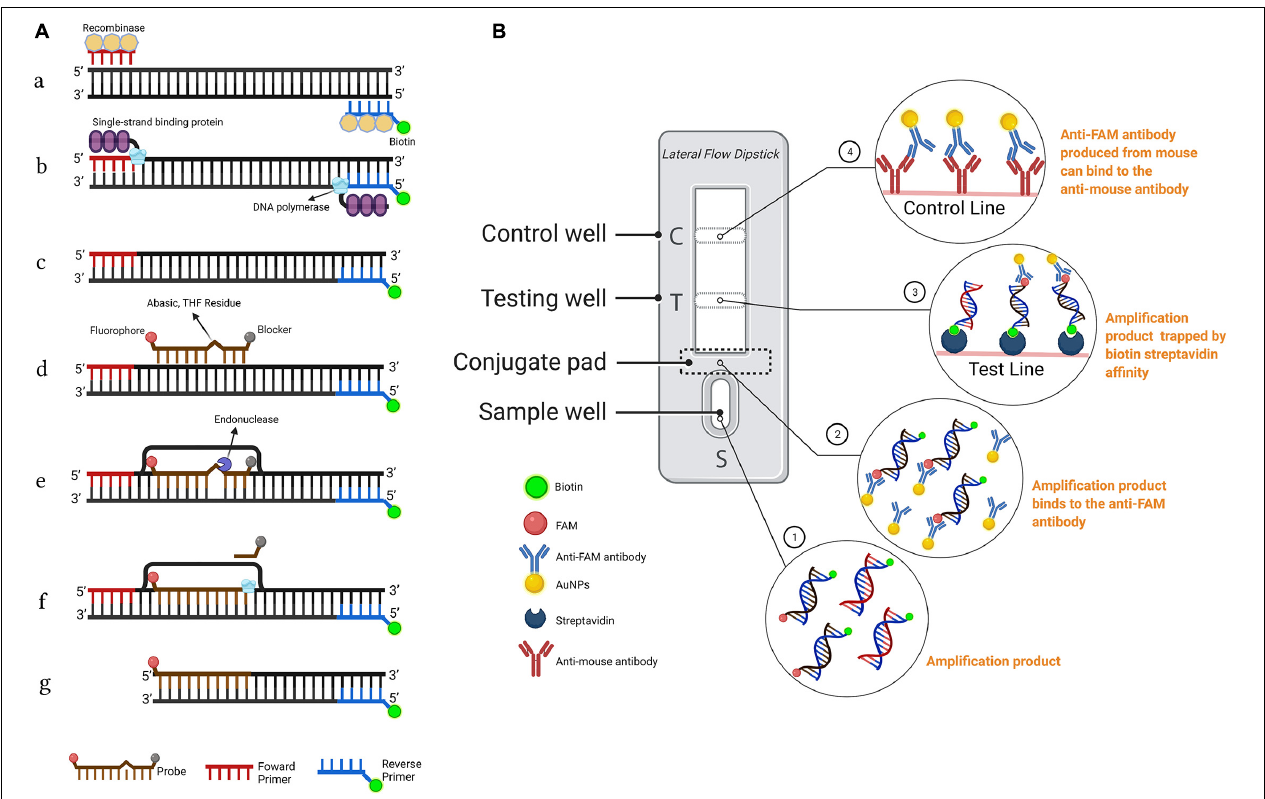
FIGURE 1 | Schematic representation of the recombinase polymerase amplification combined with lateral flow dipstick (RPA-LFD) assay. (A) Principle of RPA. DNA strands are represented by horizontal lines, and base pairings are represented by short vertical lines between DNA strands. The forward primer (F), reverse primer (R), probe (P), nfo, single strand DNA-binding protein (SSB), polymerase, recombinase, fluorophore, blocker, and tetrahydrofuran (THF) residue are shown by various color and forms and text annotation. Created with BioRender.com. (B) Schematic representation of the lateral flow dipstick working principle. Lateral flow dipstick was painted after real ones. The segment names are displayed on the left of the dipstick drawing. The direction of liquid migration is from the sample well, through the conjugate pad, to the test and control wells. The coating material on each segment of the dipstick is shown in the image to the right. Molecules can be captured by the coating material on the test line and control line. Molecules and their symbolic shape are displayed in the lower-left corner. Dipstick created with